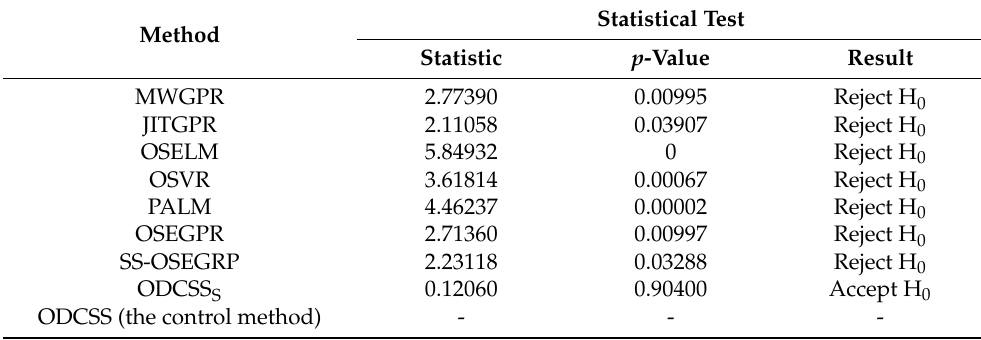
ODCSS (the control method) - -